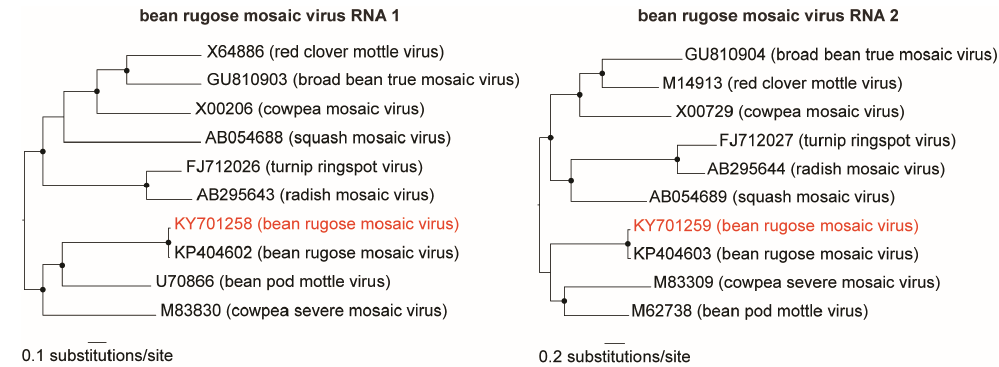
Figure 3. Maximum likelihood trees of comoviruses. The trees were inferred using all available genomes (RNA 1 and RNA 2) of members in the genus Comovirus . The trees are midpoint rooted for purposes of clarity, and the nodes indicated by a black dot have Shimodaira–Hasegawa-like branch test ≥0.9. The bean rugose mosaic virus isolate sequenced here is highlighted in red.